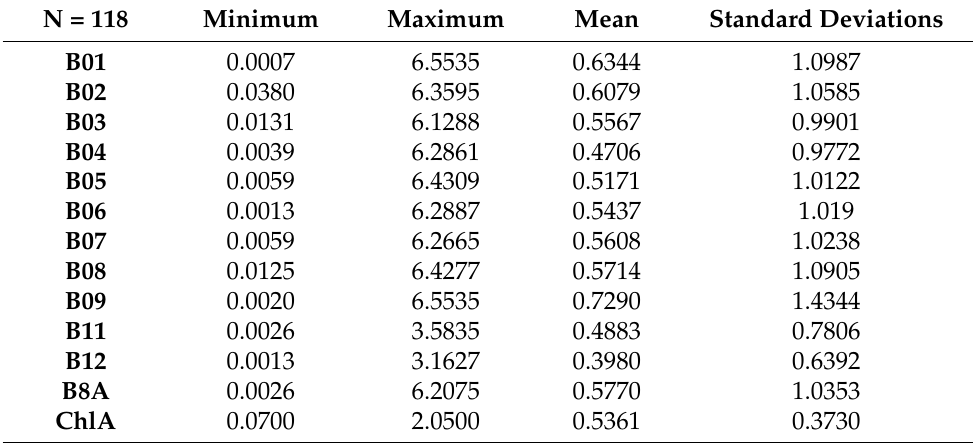
Table 3. Summary statistics of Chlorophyll-a and band